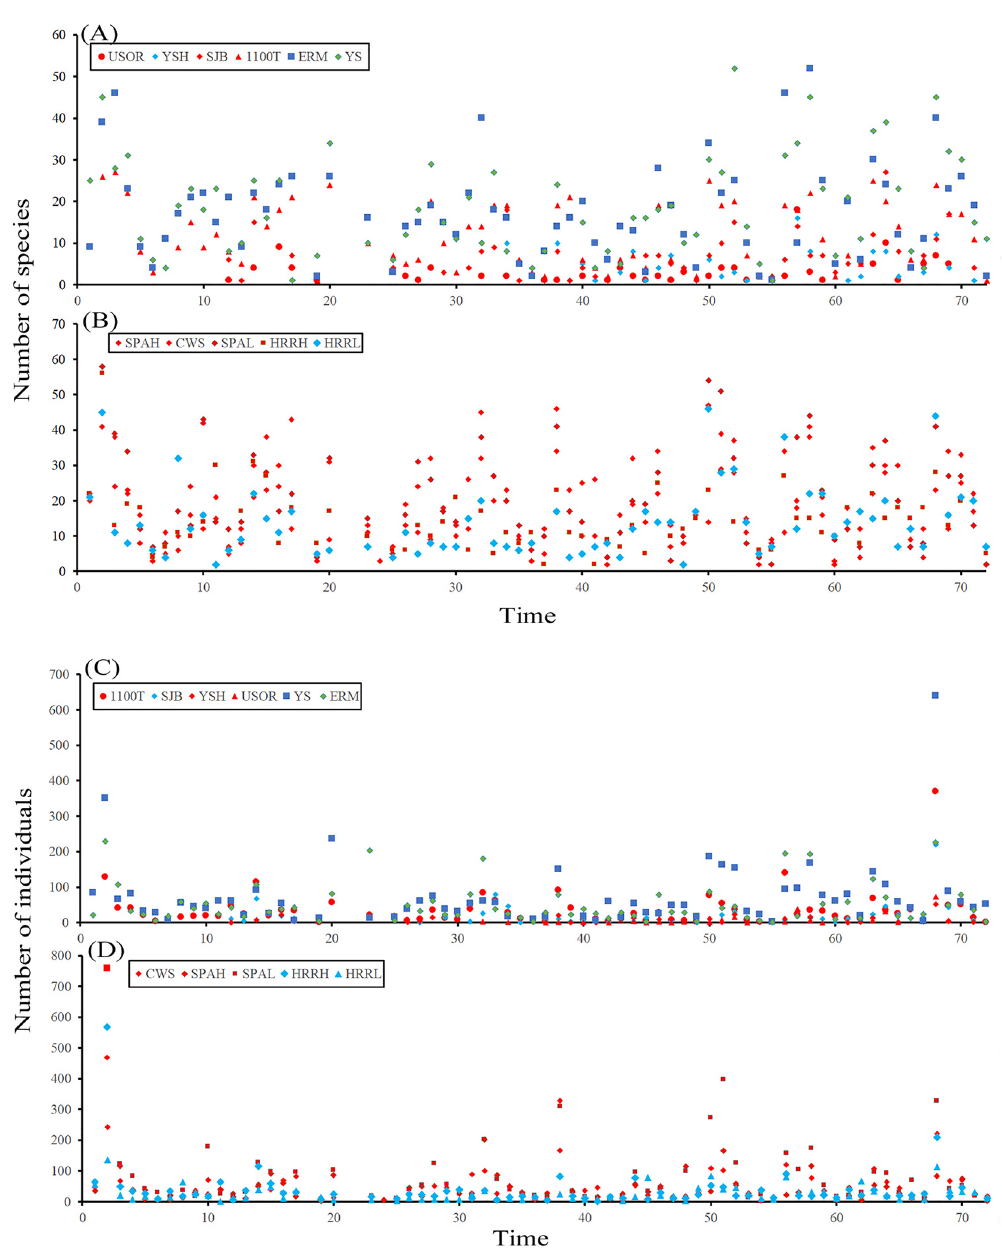
Figure 2. Scatter plot of the temporal changes in the number of species ( A , B ) and the number of individuals ( C , D ) of moths over the 12-year sampling at 11 study sites in HNP. The number of species ( A ) and individuals ( C ) at the sites is greater than 900 m a.s.l. The number of species ( B ) and individuals ( D ) at the sites is lower than 900 m